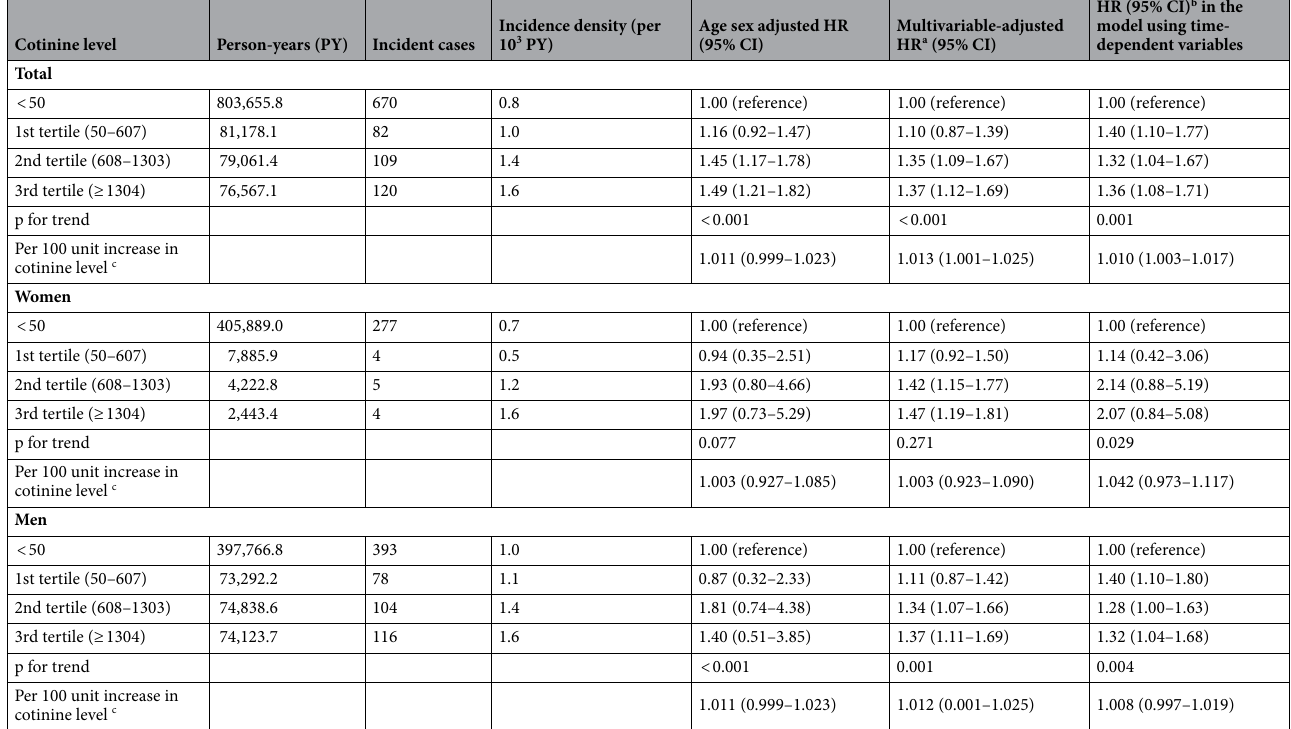
Table 4. Development of bilateral hearing loss by categories of urinary cotinine based on its distribution. The p-value for the interaction of sex and cotinine level for risk of hearing loss was 0.880. BMI body mass index, CI confidence interval, CVD cardiovascular disease, HR , hazard ratio, CI confidence interval, HR hazard ratio. a Estimated from parametric proportional hazards models. Multivariable model was adjusted for age, sex (only occupational noise exposure. b Estimated from Cox proportional hazards models with cotinine level